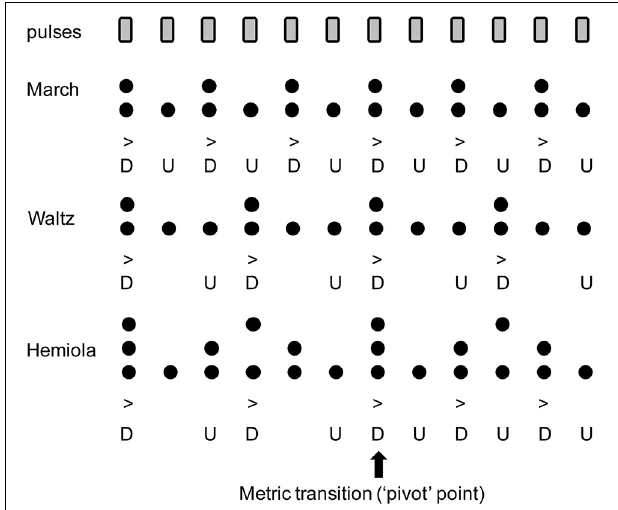
FIGURE 1 | Accent strength at each pulse position in (Top) binary “march,” (Middle) ternary “waltz,” and (Bottom) “hemiola.” Note that the upbeat positions (indicated with the letter “U”) have only one layer of metric structures, while the downbeat positions have multiple layers coinciding at the same time. This contributes to the stronger accents in the downbeats(indicatedwiththeletter“D”).Inthehemiolapattern,thenumber ofthelayersisthreeduetocoexistingbinaryandternarymeters.Atthe1stor 7th position, the strongest accent is derived because of the three coinciding accents. This point also serves as a “pivot” point that allows an intentional switch from ternary to binary